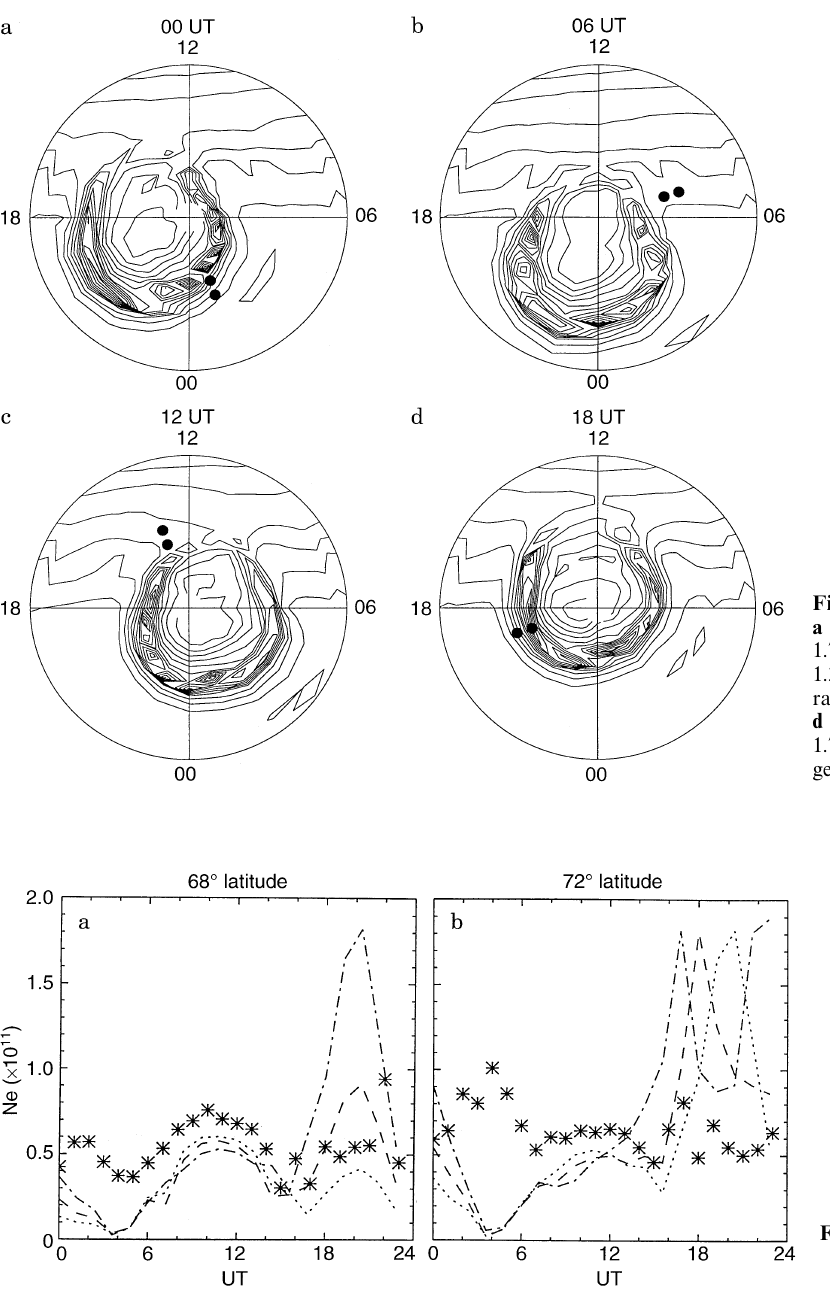
Fig. 6a, b. Same as Fig. 4 but for RUN-1